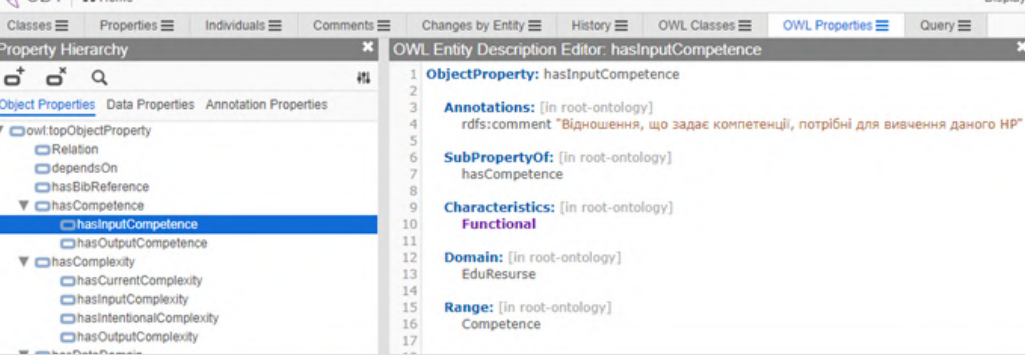
Figure 4: Presentation of paper